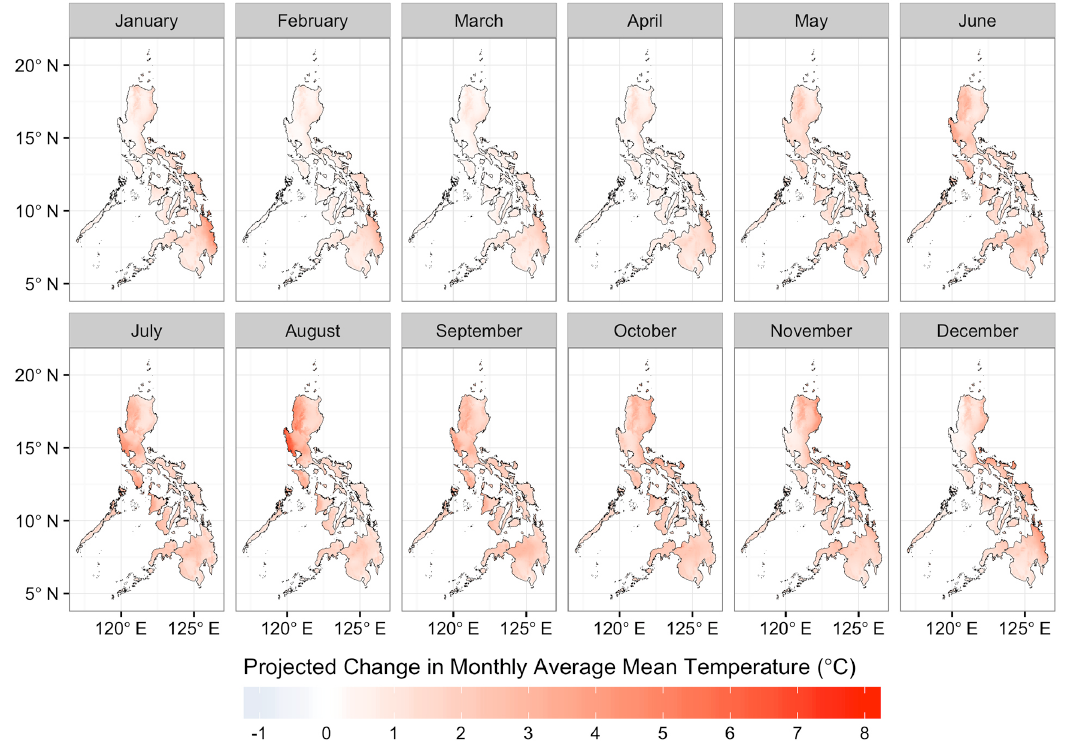
Fig. 6. Spatial distribution of projected changes in monthly average mean temperature in the Philippines under future climate condition (2041–2060).